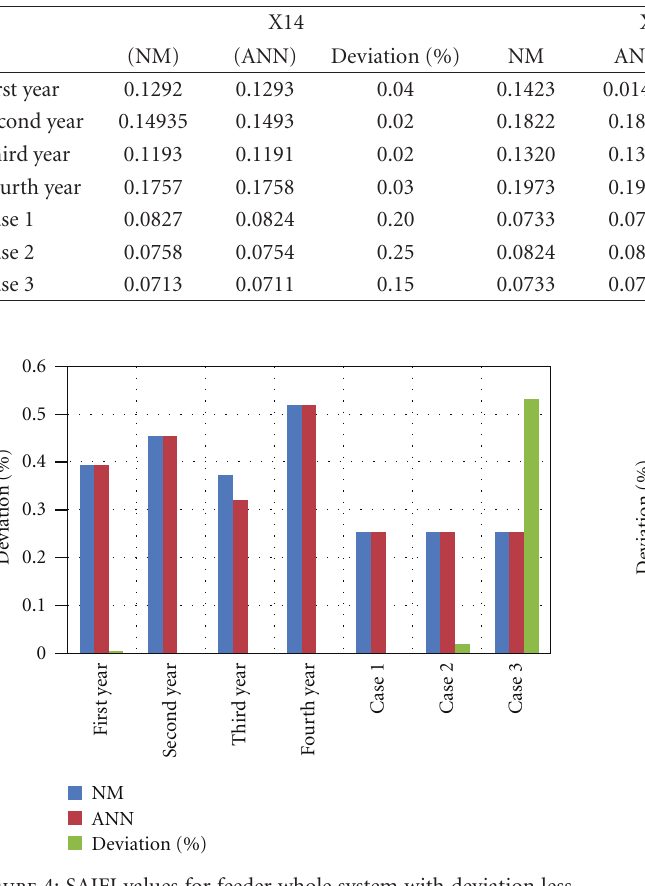
Figure 5: SAIDI values for feeder X14 with deviation less than 0.25.